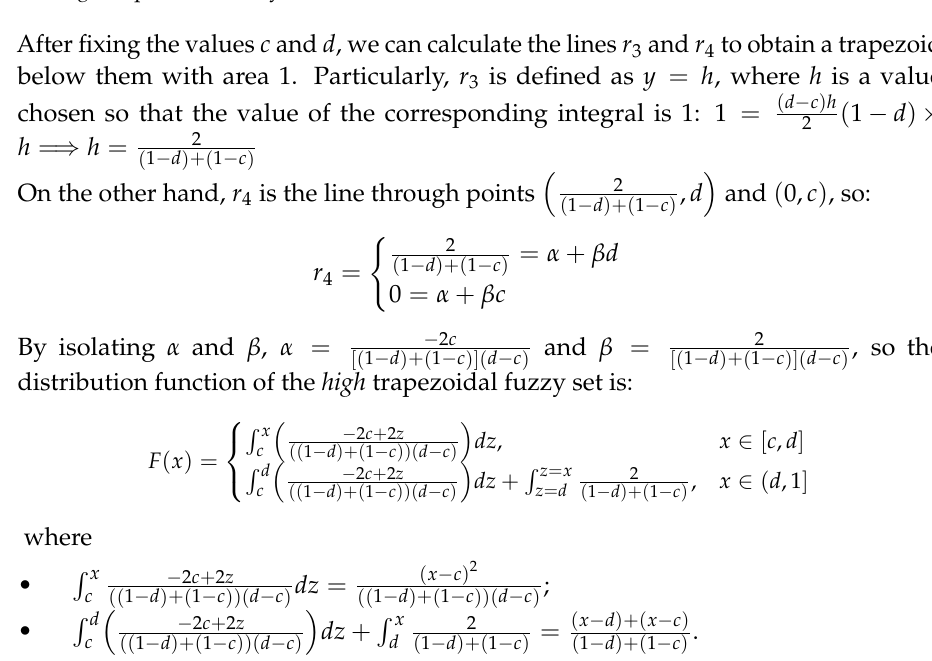
Figure 7. High trapezoidal fuzzy